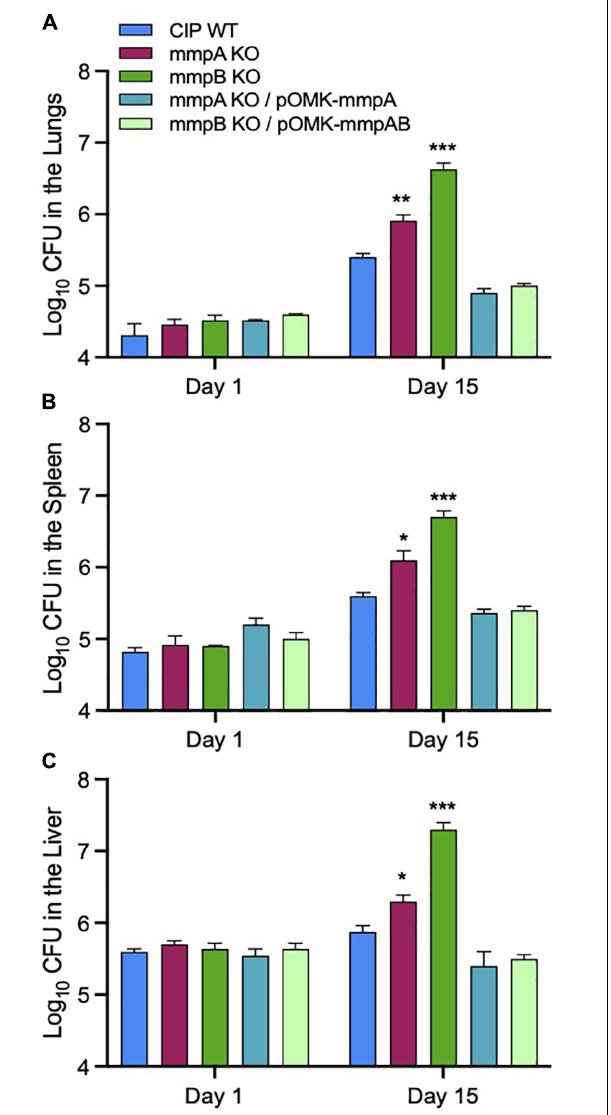
FIGURE 7 | Increased bacterial load in the lungs, spleens and livers of SCID mice infected with the Mmas porin knock-out strains. Bacterial counts in the lungs (A) , spleens (B) and livers (C) on days 1 and 15 from SCID mice intravenously infected the WT, porin mutant and complemented mutant strains. Results are expressed as the average ( n = 5) of the bacterial load in each group expressed as Log10 CFU ± standard error mean (SEM). Growth of the two porin knock-out mutants was significantly higher than that of the WT parent strain pursuant to the Student’s t -test (* P < 0.0005; ** P < 0.00005; *** P <